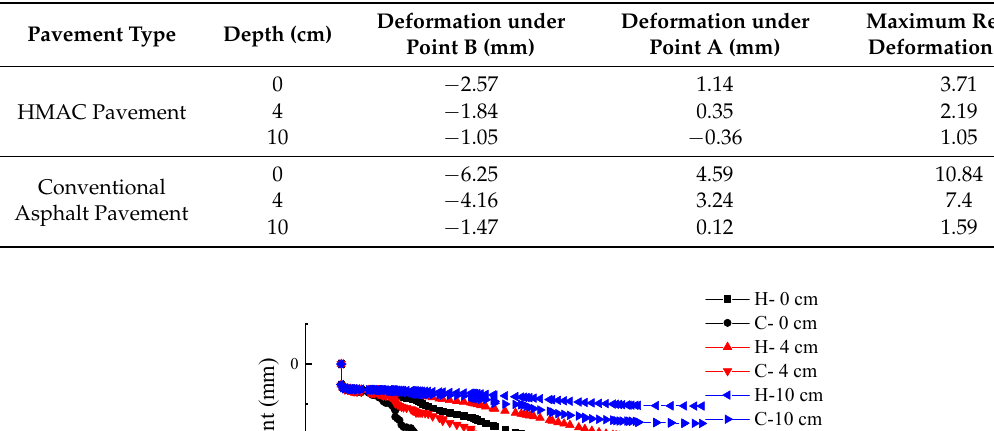
Table 15. Material parameters of middle surface layer of conventional asphalt pavement.